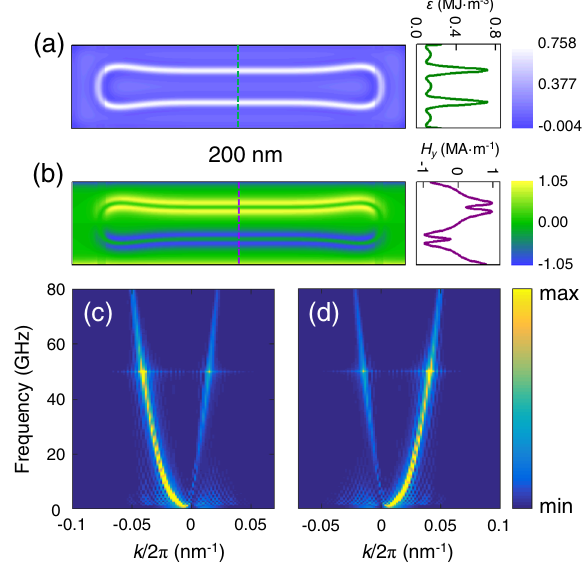
Fig. 7 Properties of an elongated skyrmion acting as a magnonic waveguide. Maps of a the total energy density ε and b the effective fi eld H y for the system with an elongated skyrmion. The insets at the right show eff the corresponding ε and H y along the central vertical line, x = 200 nm. eff Dispersion relations for c the lower branch y = 30 nm and d the upper branch y = 70 nm of the elongated skyrmion. These three color bars denote the total energy density, the effective fi eld and the fast Fourier transform (FFT) amplitude,